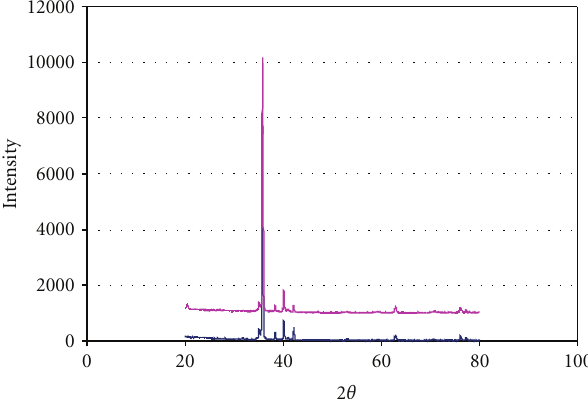
Figure 3: X-ray di ff raction spectra of Porous and PorousNano